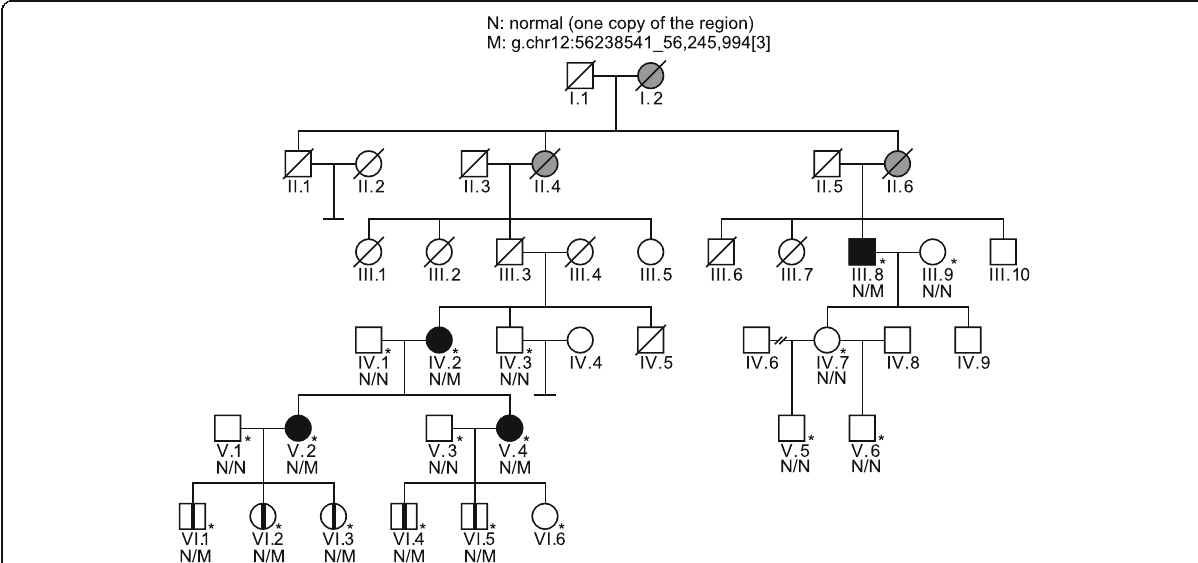
Fig. 1 Pedigree of family with cavitary optic disc anomaly. Clinically affected individuals are represented by black symbols, presumably affected individuals are represented by gray symbols, unaffected individuals are represented by open symbols, and asymptomatic carriers are represented by an open symbol with a vertical black line. Examined individuals are marked with asterisks (*). Alleles are denoted by N: normal (one copy), and